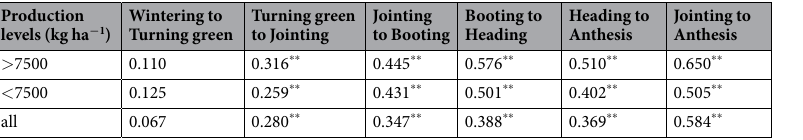
Table 2. Pearson’s correlation between grain number per spike and dry matter accumulation rates at different stages. Notes: n = 228; * Significant at the 0.05 probability level; ** Significant at the 0.01 probability